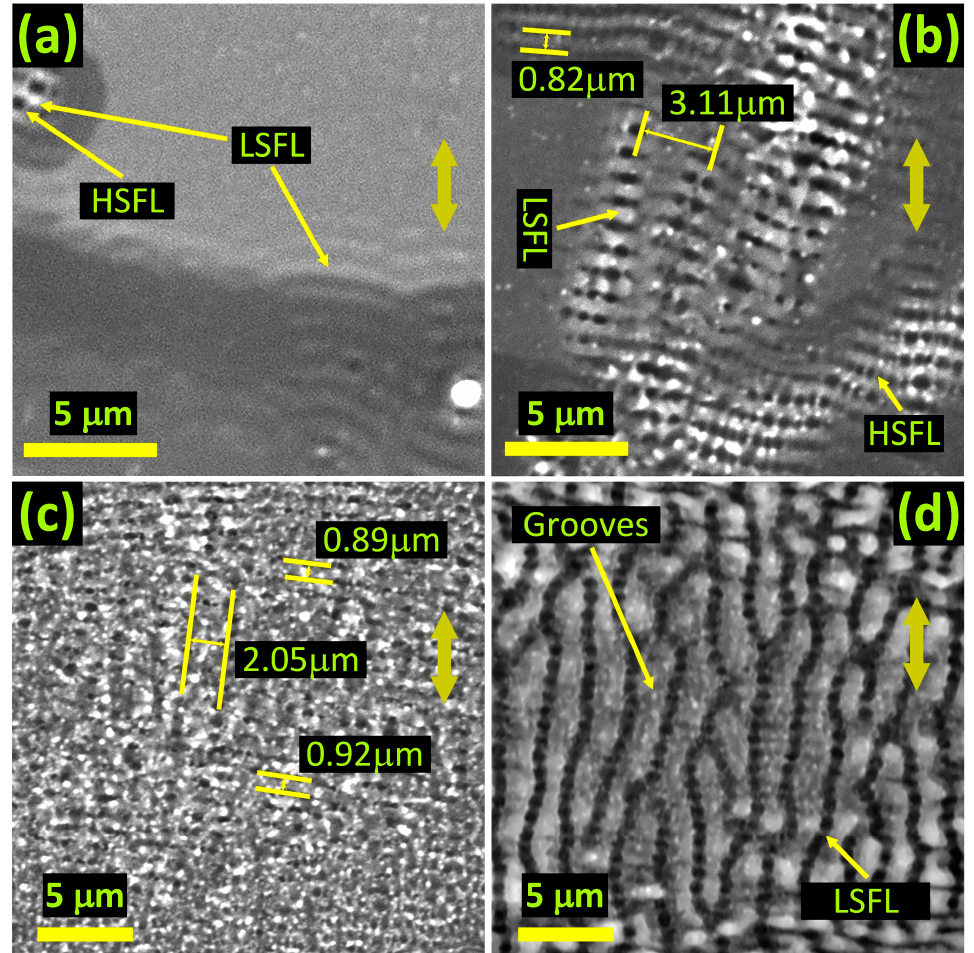
Figure 6. ( a ) SEM micrographs of laser-modified spot areas irradiated with ( a ) N = 5, ( b ) N = 10, ( c ) N = 20, and ( d ) N = 200 pulses of 78 fs and 0.7 J/cm 2 fluence.